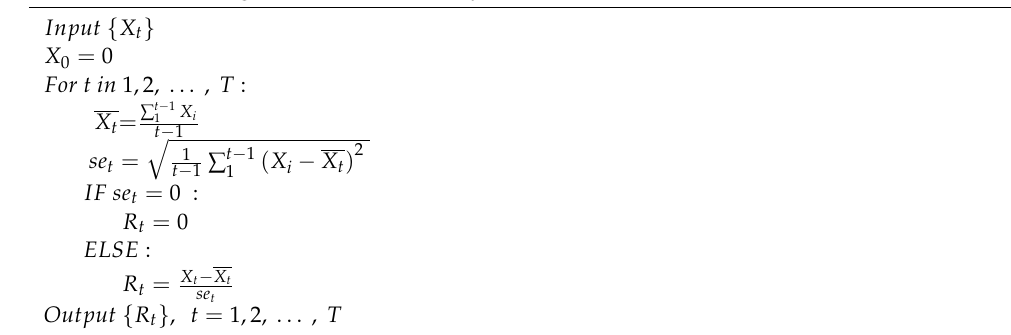
Algorithm 1. Dynamic perceived risk perception by moving average and moving standard deviation with window size as N. Algorithm 2 Moving z-score with all history information